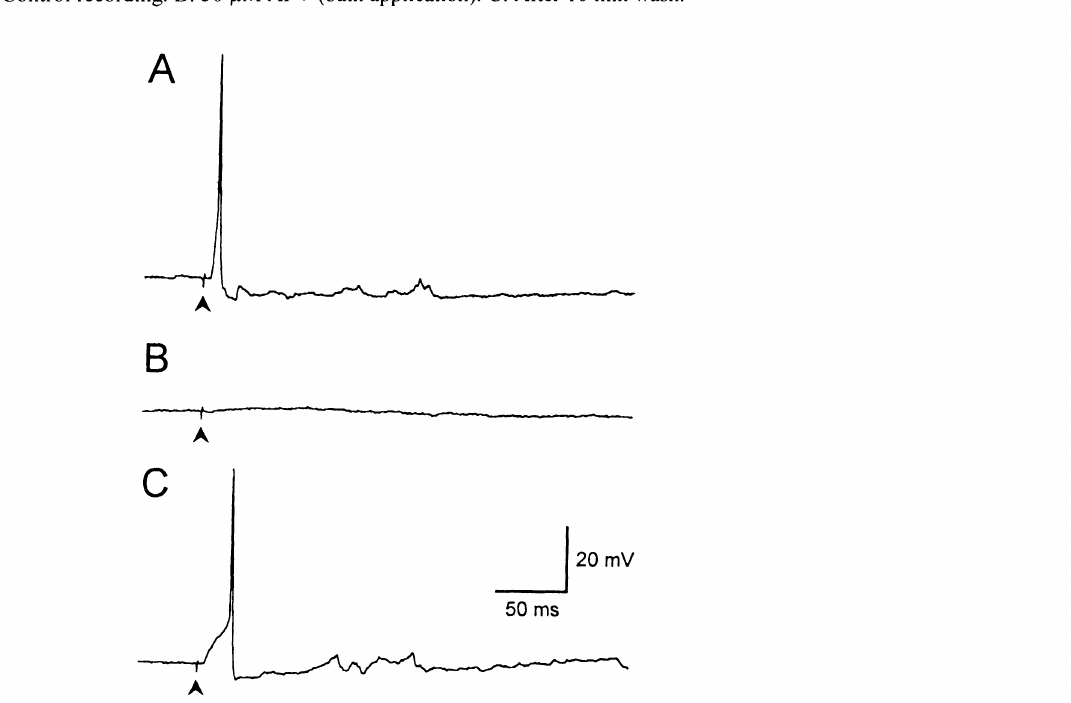
Fig. 9: CNQX blocks the response of an MNH neuron to single thalamus stimulation. Stimulus artifacts are indicated by arrowheads. A" Control recording. B: 10 laM CNQX (bath application). C: After 20 min